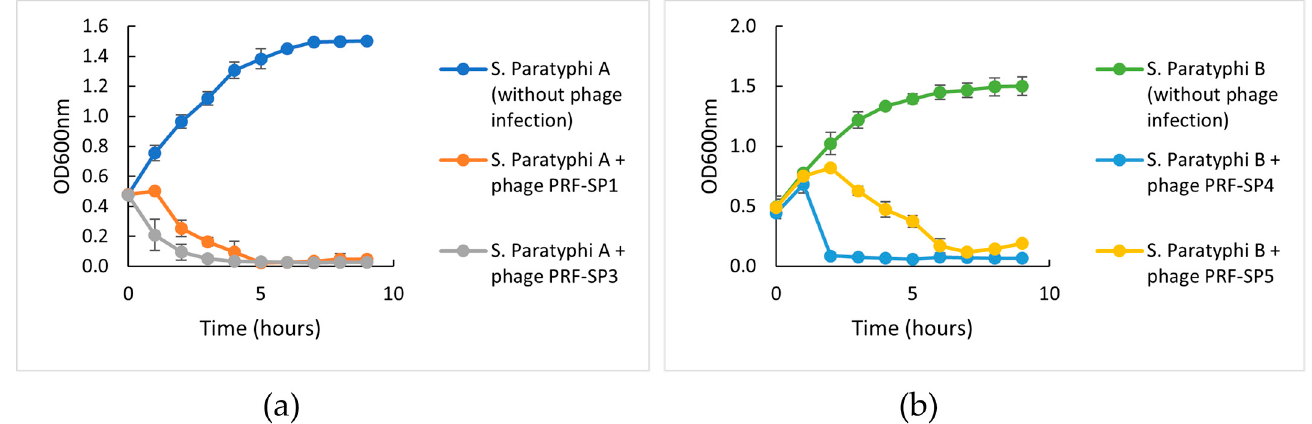
Figure 3. Bacterial challenge test of phages against their respective host Salmonella serovars. ( a ) Bacterial challenge test of phage PRF-SP1 and PRF-SP3 against S . Paratyphi A. S . Paratyphi A without phage infection was used as control. ( b ) Bacterial challenge test of phage PRF-SP4 and PRF-SP5 against S . Paratyphi B. S . Paratyphi B without phage infection was used as control. OD 600nm was measured via a spectrophotometer.